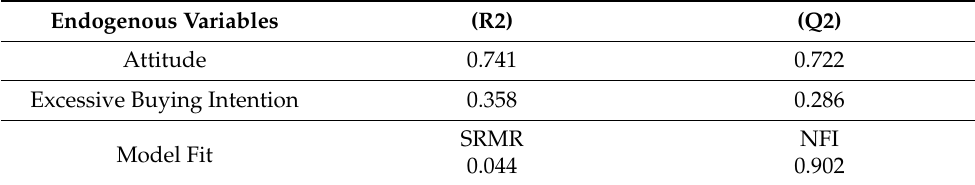
Table 4. Goodness-of-fit index.